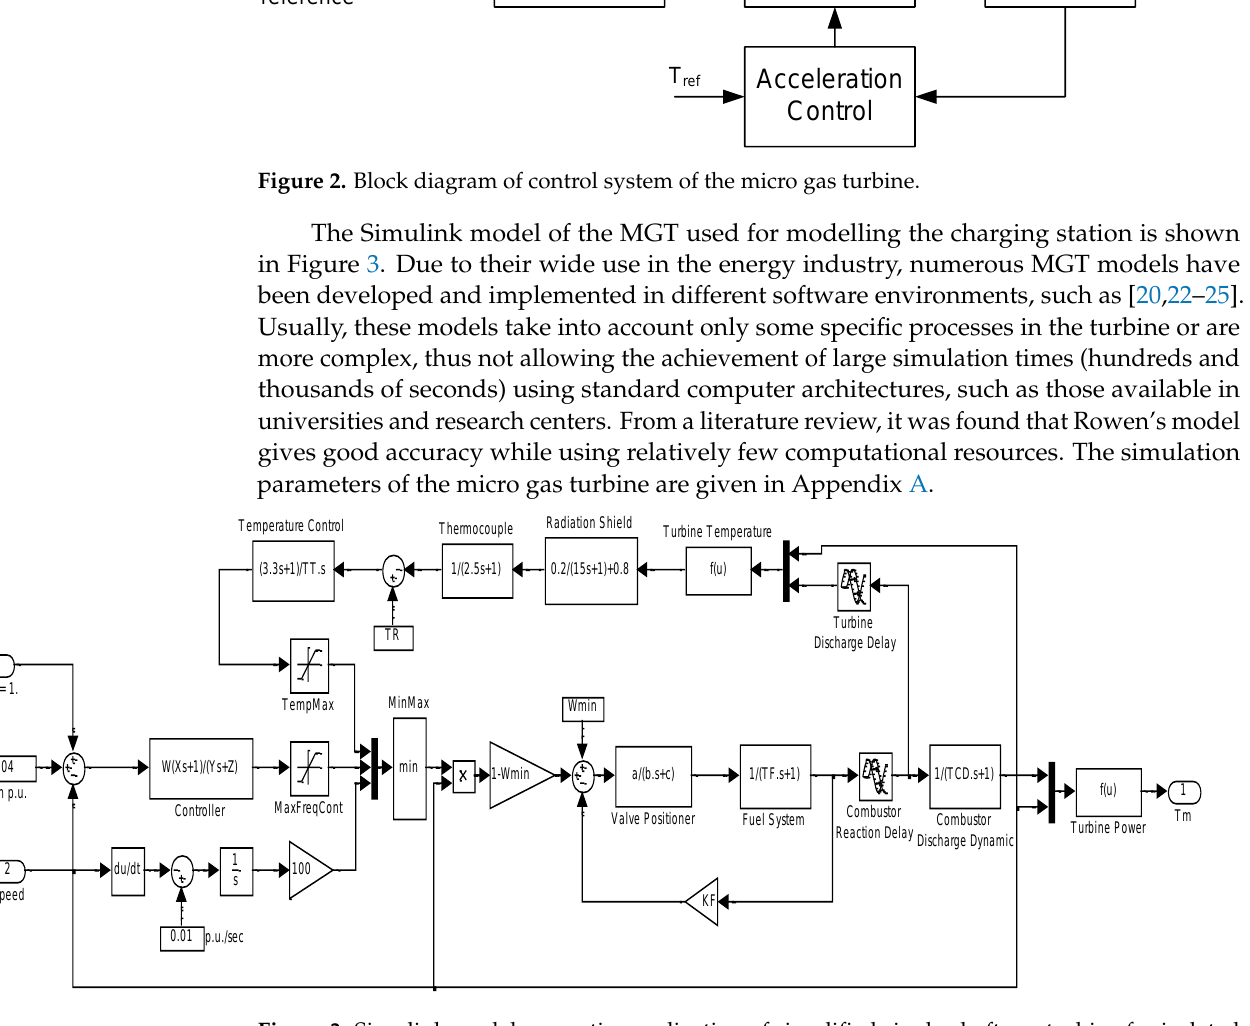
Figure 2. Block diagram of control system of the micro gas turbine.